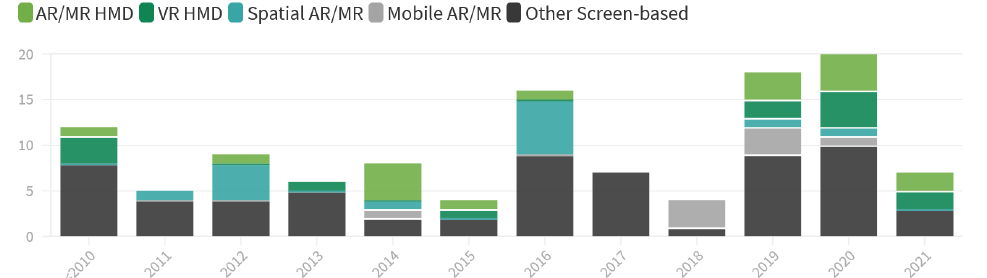
Figure 9. Used Output Technologies over the